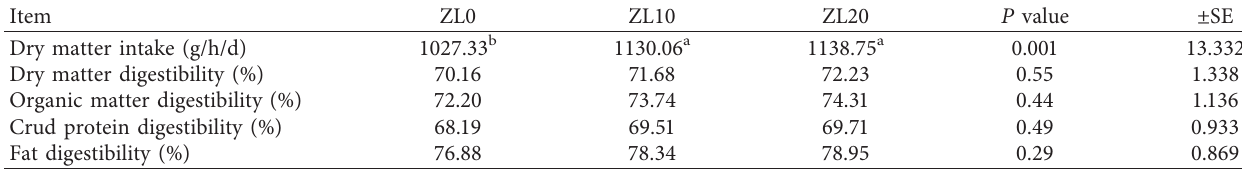
Table 7: Effects of dietary ZL supplementation on estimating apparent nutrient digestibility of growing rabbit